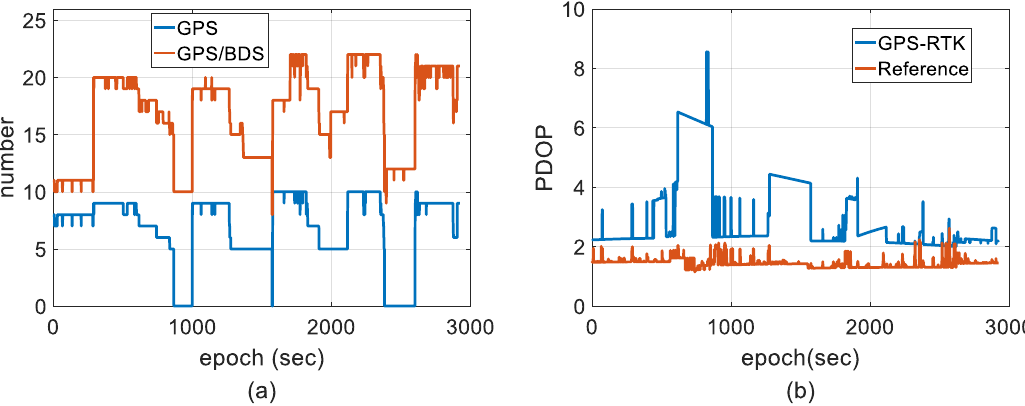
Figure 5. Distributions of valuable satellite number and PDOP. ( a ) Number of satellites and ( b ) PDOP.